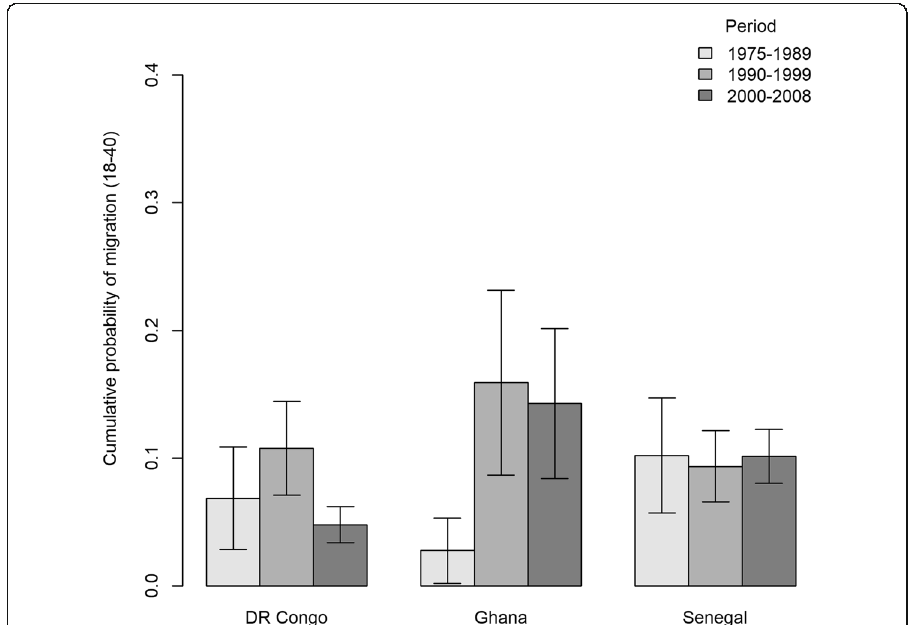
Fig. 7 Lifetime probability of migration to Europe by origin country (1975 – 2008). Source: MAFE Household surveys, in Senegal, DR Congo, and Ghana, 2008-2009. Weighted figures (90% confidence intervals). Population: All household heads ’ children (between age 18 and 40), whatever the age of departure, including deceased children. Definition: Migration for a period of at least one year. Interpretation: Each bar represents those who left DR Congo, Ghana, or Senegal as a proportion of those who were living there during the period in question (age is controlled for). For more technical details on the computation methodology, see Schoumaker and Beauchemin